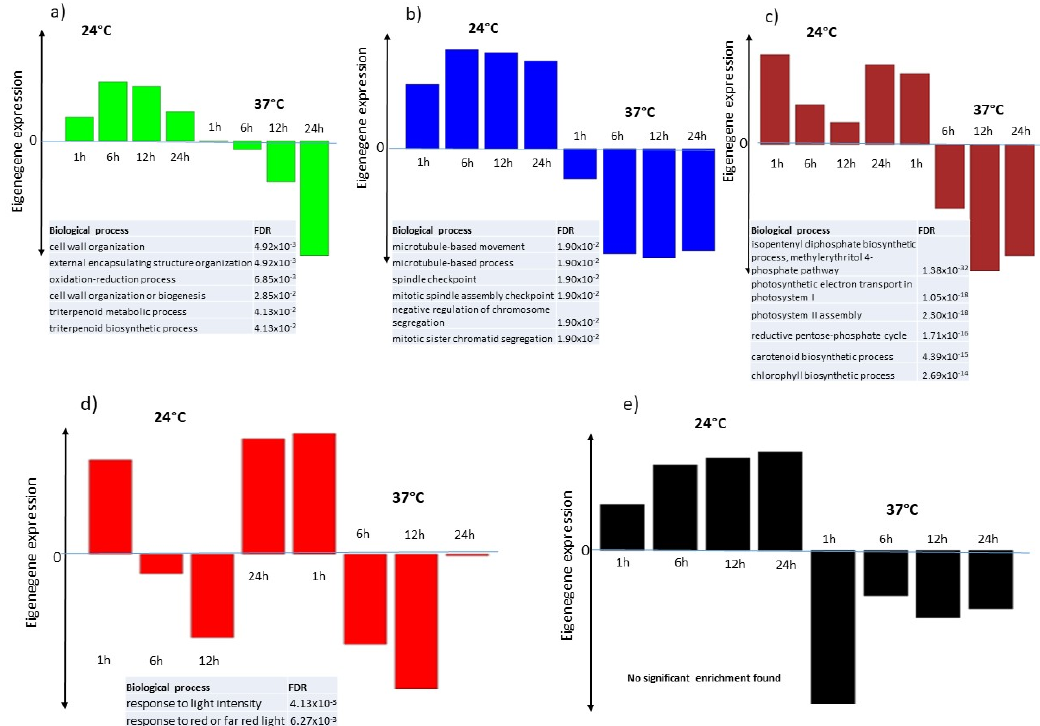
Figure 8. Eigengene expression of the green ( a ), blue ( b ), brown ( c ), red ( d ) and black ( e ) WGCNA modules containing genes down-regulated by temperature increase. The histogram bars represent the eigengene expression of each module in samples grown at 24 or 37 ◦ C for 1, 6, 12, 24 h. The GO term enrichment is represented in the lower part of each figure